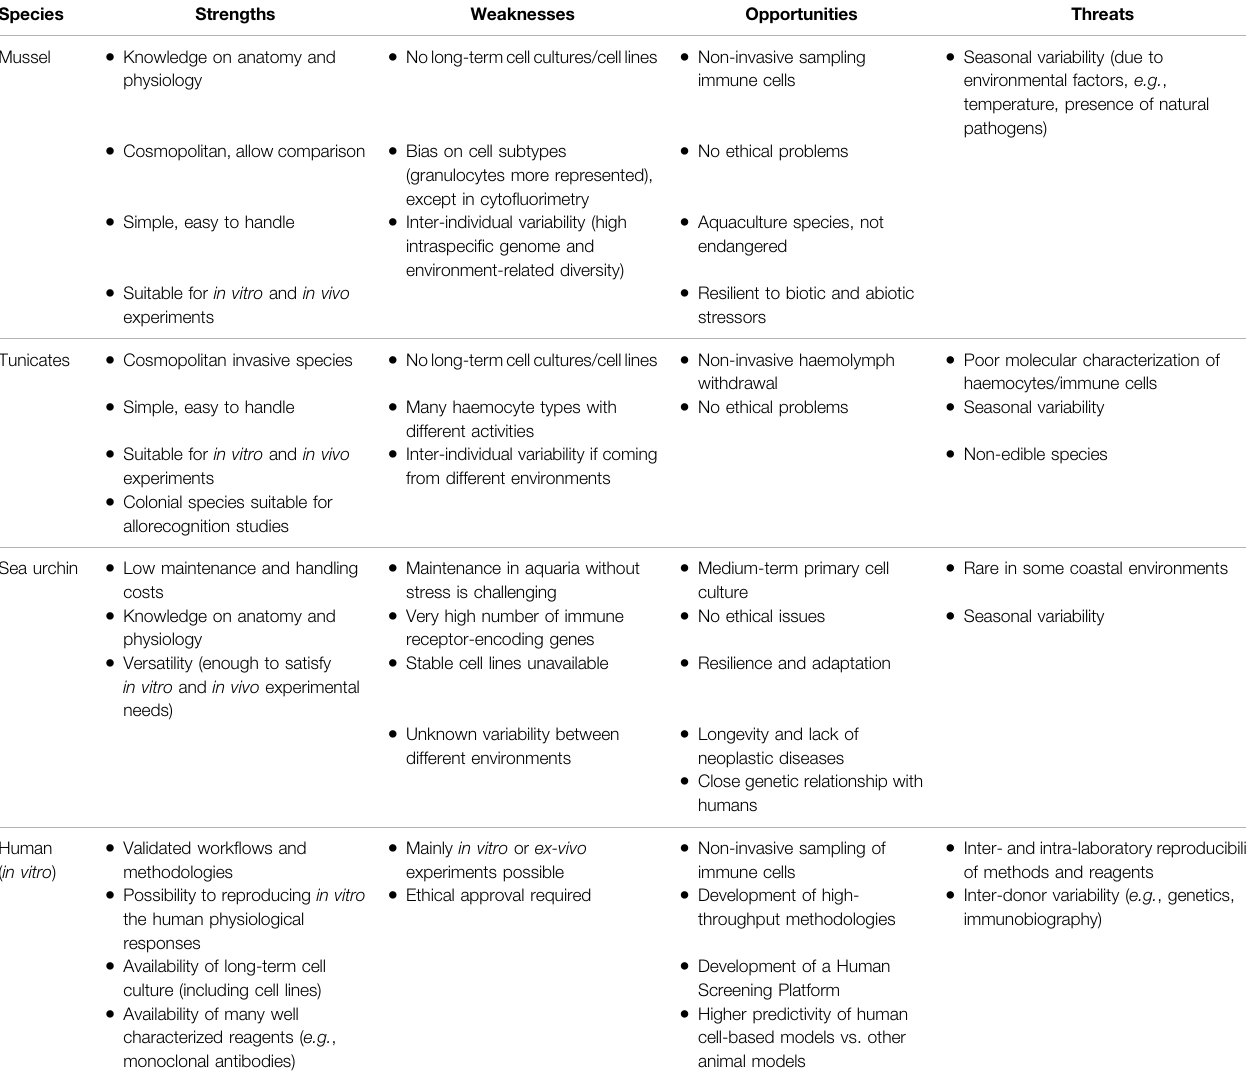
TABLE 1 | SWOT analysis of animal species for immunotoxicological assessment. Species Strengths Weaknesses